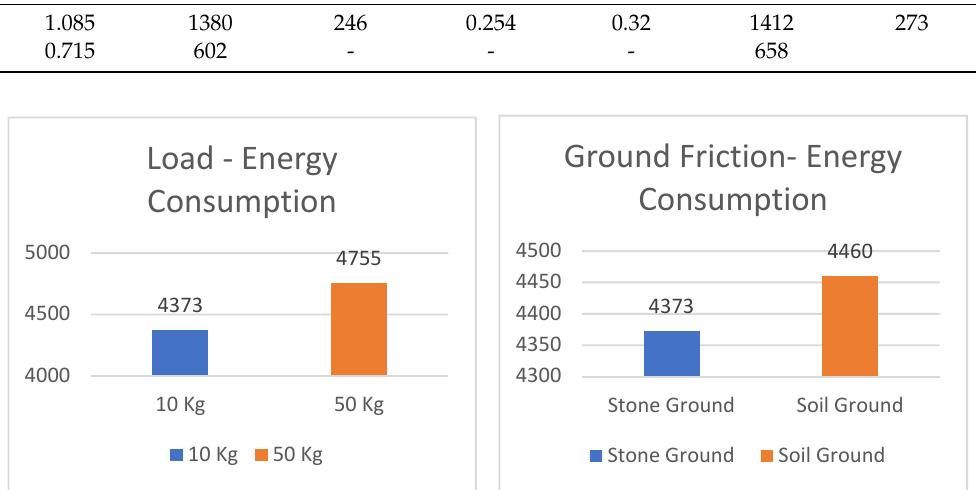
Figure 15. Effect of load and ground changes on energy consumption.